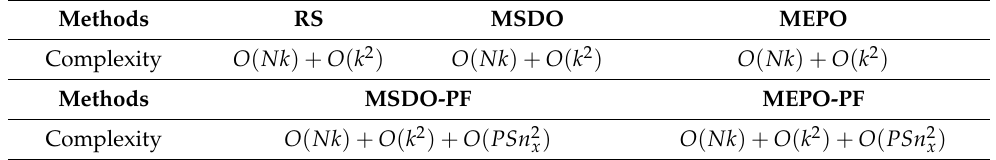
Table 1. Complexity analysis of the localization methods.